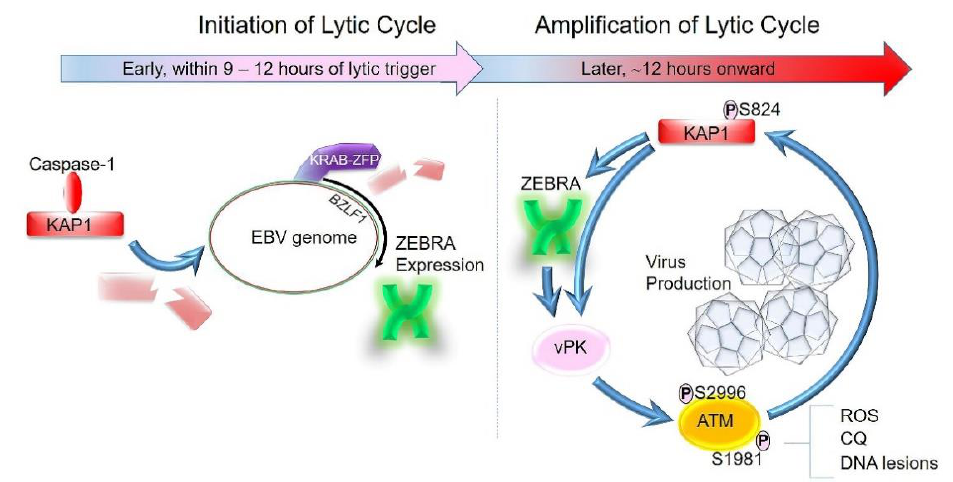
Figure 2. EBV lytic activation from latency proceeds in two stages: initiation and amplification. During initiation, exposure to a lytic trigger/cellular signal results in activation of the inflammasome, thereby activating caspase-1 that destabilizes KAP1, resulting in its depletion. Depletion of KAP1, a key regulator of heterochromatin, allows cellular transcription factors to activate expression of BZLF1 , which encodes the lytic switch protein ZEBRA, a viral bZIP transcriptional activator (green dimer). These early events within 9 to 12 h of lytic stimulus are followed by an amplification stage in which ZEBRA participates in transactivating its own promoter as well as the promoters of other lytic genes, including replication and transcription activator (RTA). While reactive oxygen species (ROS), DNA damage, or chloroquine (CQ) can activate ATM via phosphorylation at Serine 1981 (S1981), ZEBRA-driven expression of the viral protein kinase (vPK) leads to vPK-mediated phosphorylation/activation of ATM at a non-canonical phospho-residue, S2996. Activated ATM then phosphorylates KAP1 at S824, deactivating KAP1 and antagonizing its ability to condense chromatin. This causes further de-repression of BZLF1 as well as other early and late lytic genes (also silenced by the KRAB–KAP1 machinery), thereby amplifying the lytic cascade.